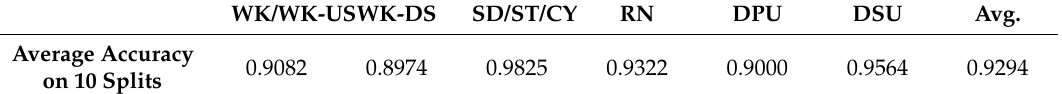
Table 12. Average F 1 accuracy calculating 10 splits on motion sensor data in the Multimodal Dataset.